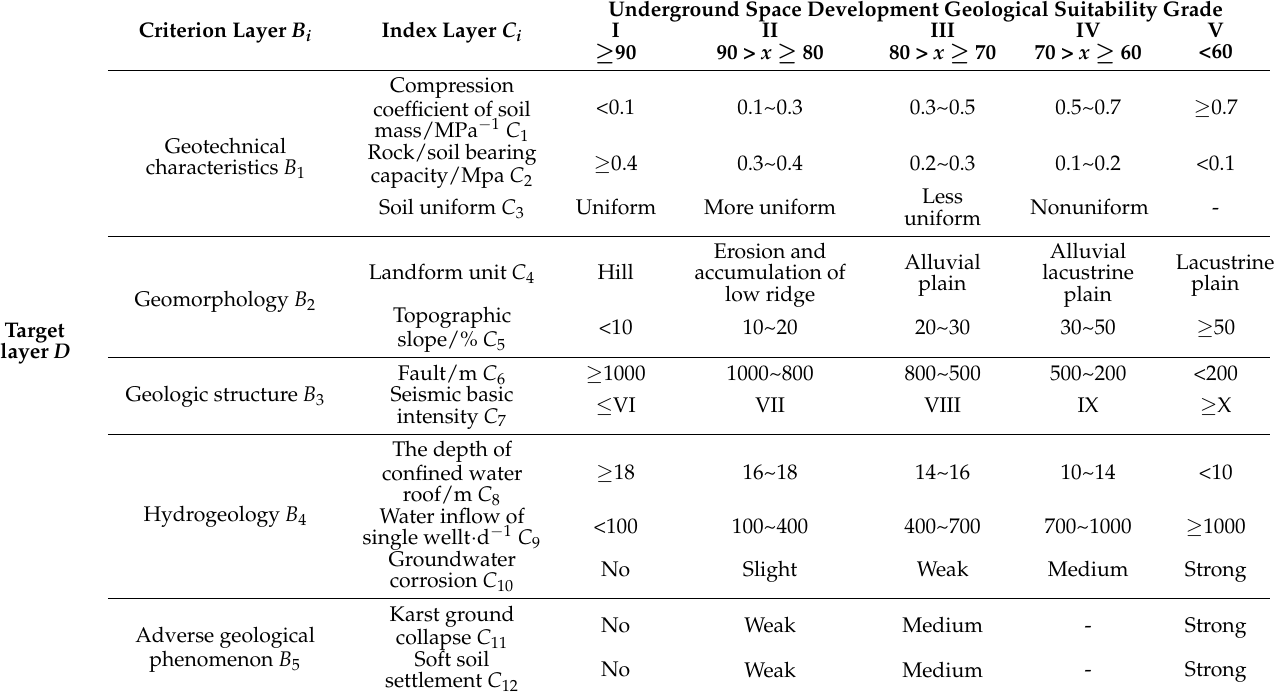
Table 1. Index selection and quantification classification.